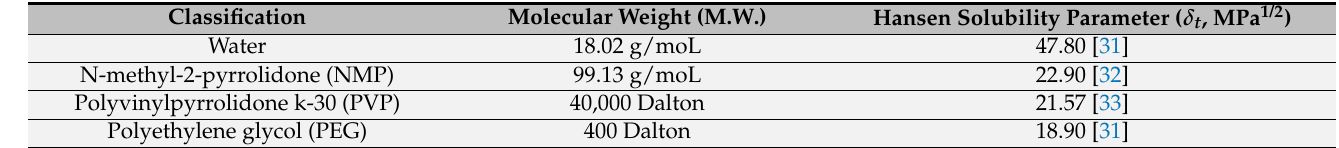
Table 3. Intrinsic properties of components in dope solution and non-solvent.